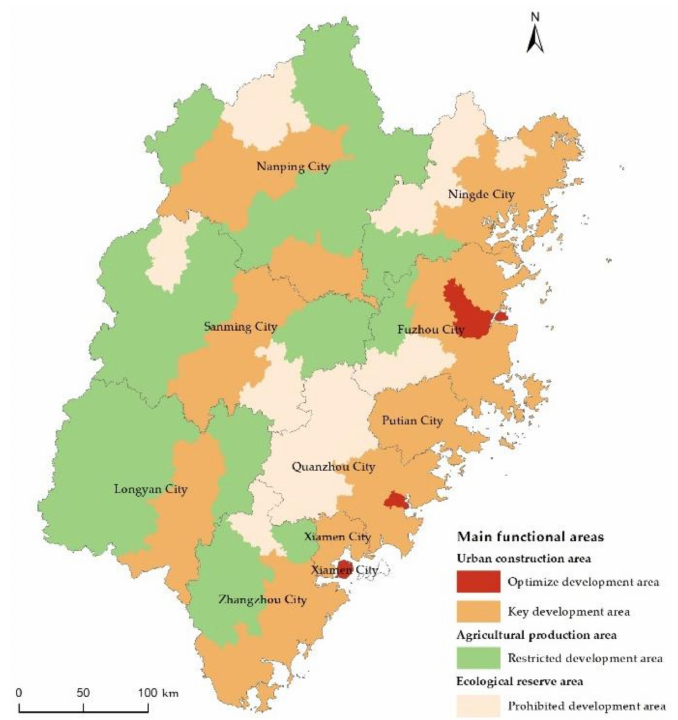
Figure 2. The main functional zoning of Fujian